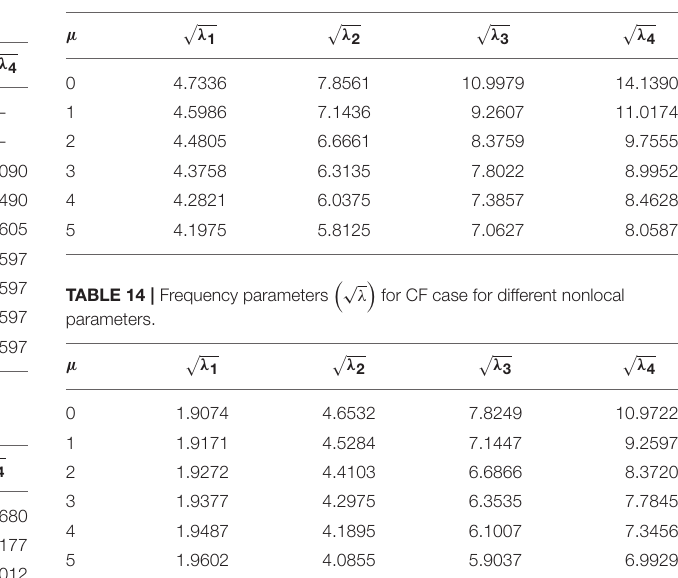
TABLE 13 | Frequency parameters parameters.